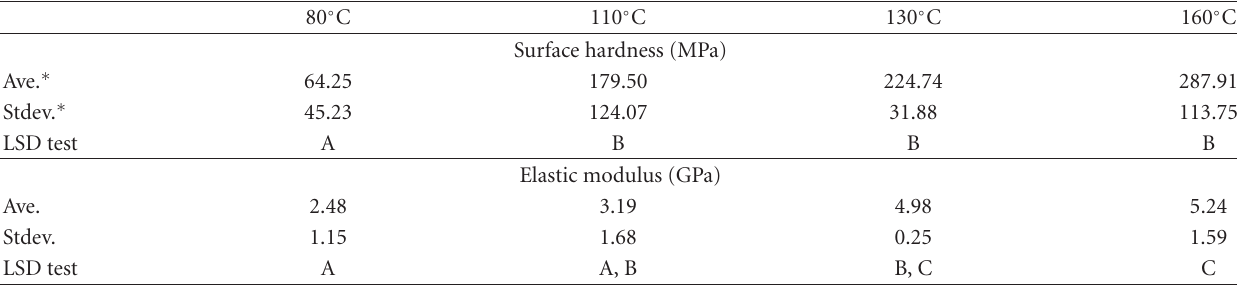
Table 3: Surface hardness and elastic modulus of digested fibers.